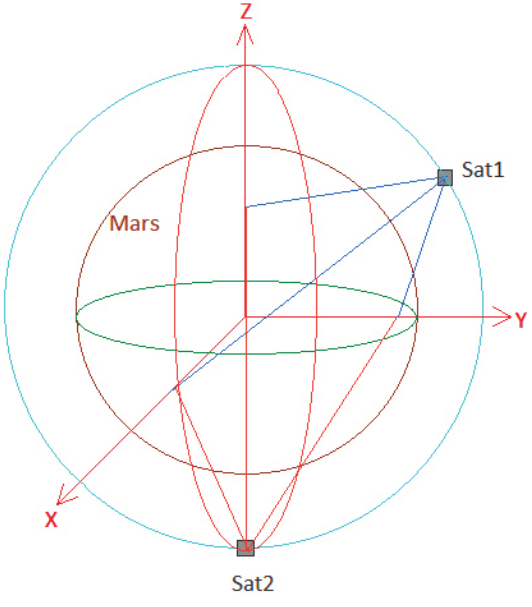
Fig. 1. Coordinate system with the example of two